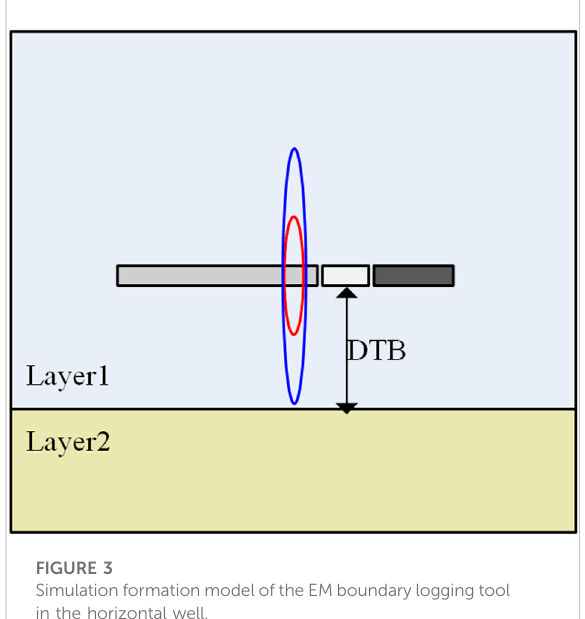
FIGURE 3 Simulation formation model of the EM boundary logging tool in the horizontal well.